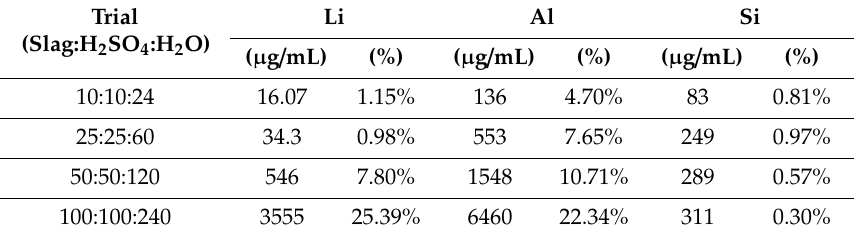
Table 7. AAS analysis of the solutions obtained by washing of the leaching residues by 500 mL of H 2 O.